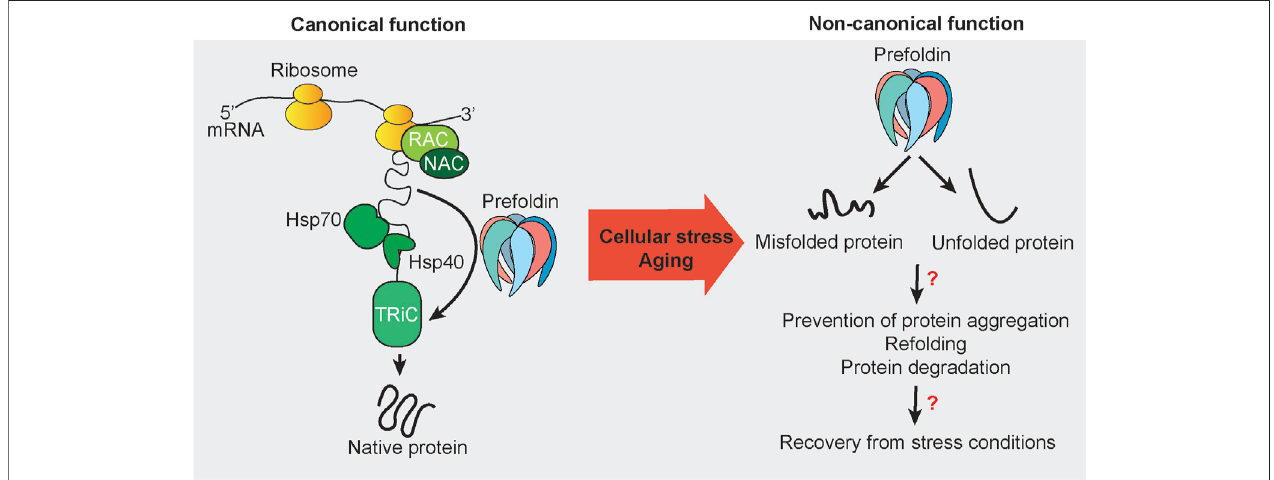
FIGURE 1 | Canonical and non-canonical functions of prefoldin. Nascent chains that emerge from actively translating ribosomes are subjected to protein folding that is mediated by the protein chaperones RAC, NAC, Hsp70, Hsp40, and TRiC. Some newly synthesized proteins utilize the co-chaperone prefoldin to guide substrates directly to its downstream folding chaperone TRiC. The canonical function of prefoldin results in substrate proteins with the native fold. Under stress conditions and potentially during aging, prefoldin is associated with misfolded and unfolded proteins. Mostly unknown are the nature of such cellular substrates in vivo and cellular consequences and mechanisms that may be necessary to recover from cellular stress conditions to restore cellular